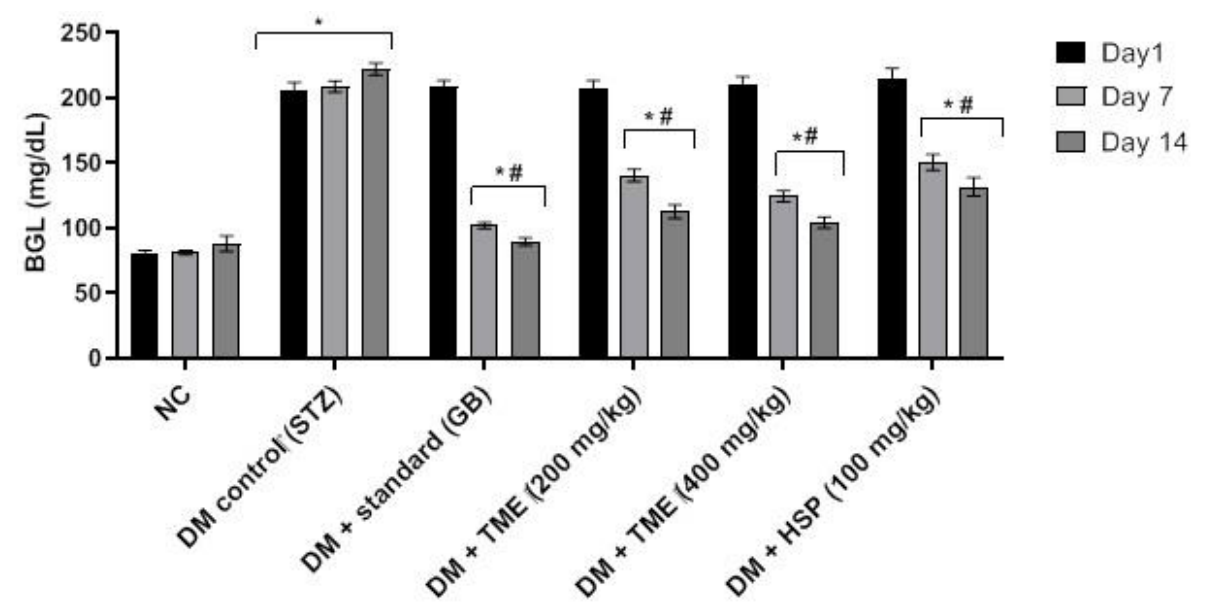
Figure 2. The effect of TME (200 and 400 mg/kg) and HSP (100 mg/kg) on STZ + HFD-induced diabetes. Results are presented as mean ± SD ( n = 6); * significant difference between control group and all the other treatment groups; # significant difference between diabetic nontreated group and all treatment groups (TME and HSP). NC, normal control; TME, total methanol extract; HSP, hesperidin; STZ, streptozotocin; GB, glibenclamide; DM, diabetes mellitus; BGL, blood glucose